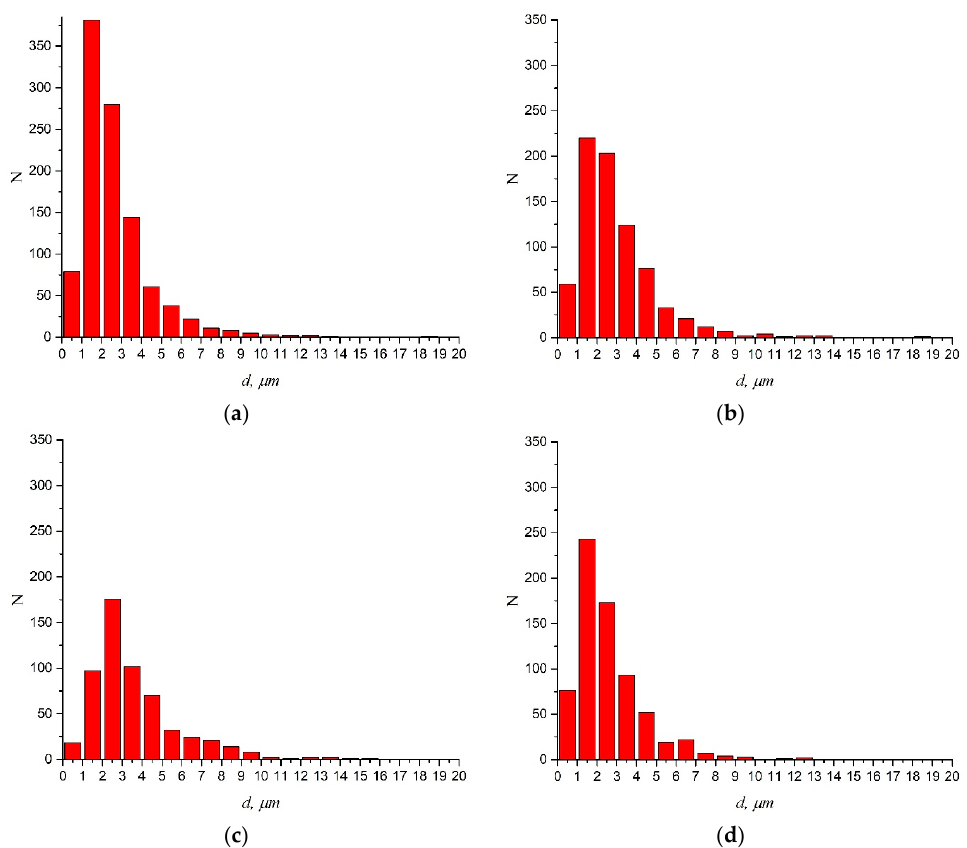
Figure 4. Distributions of equivalent diameters d eqv of dimples for alloys VT23 ( a ) and VT23M ( b – d ) under static ( а , b ) and impact ( с , d ) loading.